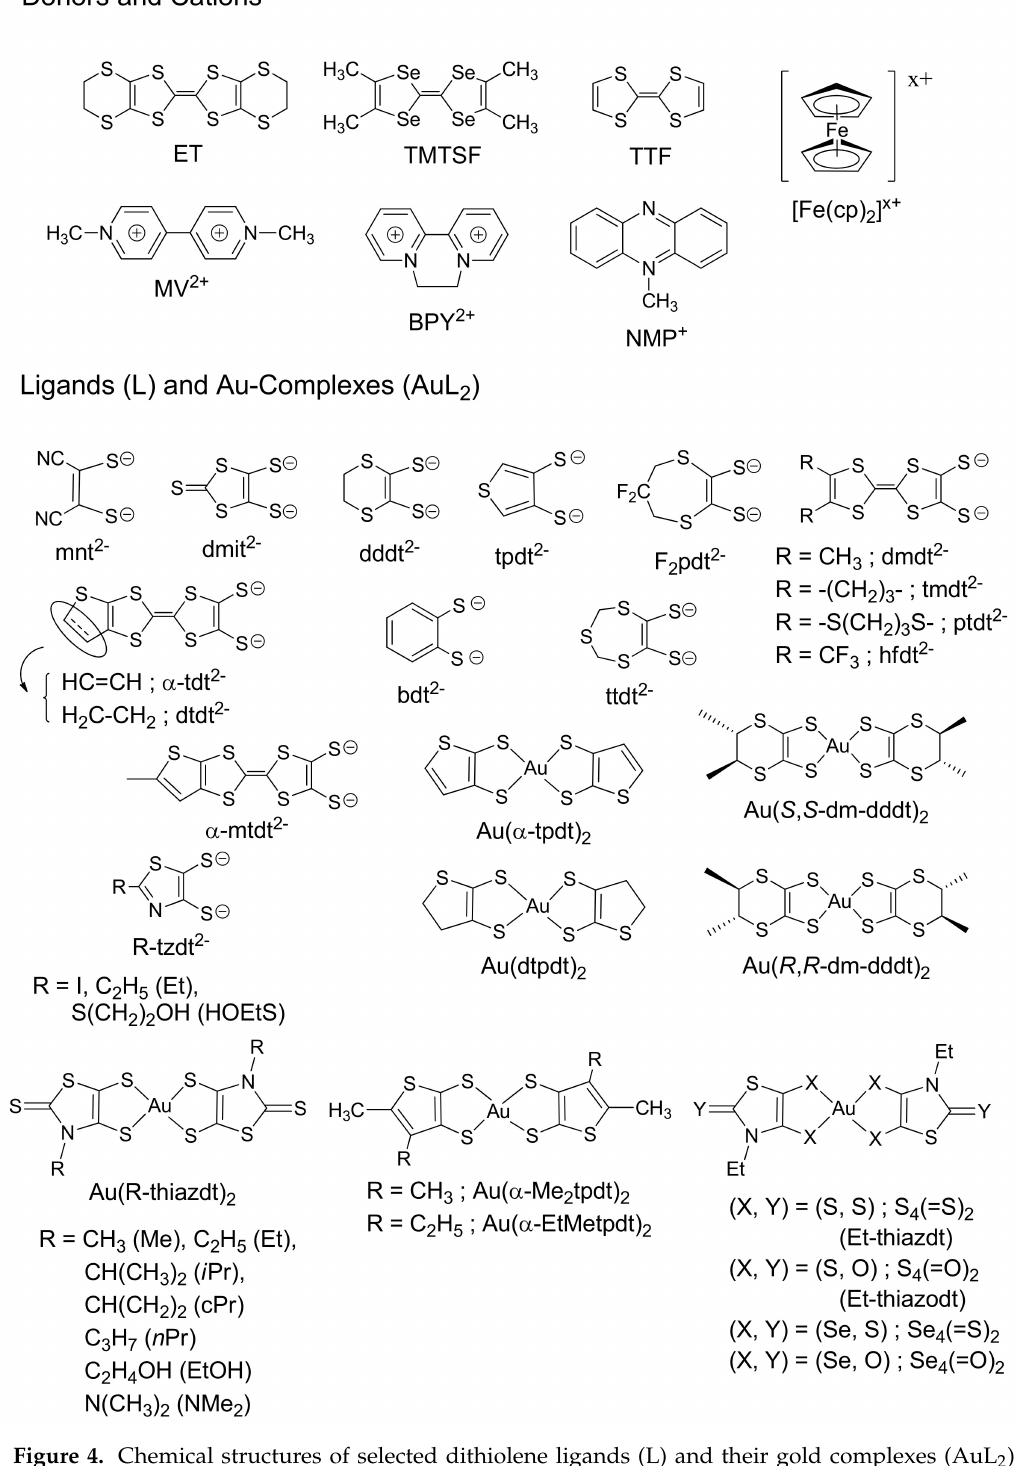
Figure 4. Chemical structures of selected dithiolene ligands (L) and their gold complexes (AuL 2 ) discussed in this paper. Unless there are isomers for AuL 2 , only L is shown; otherwise, only the relevant isomers to those in Tables 1 and 2 are shown. There are some ligands without particular